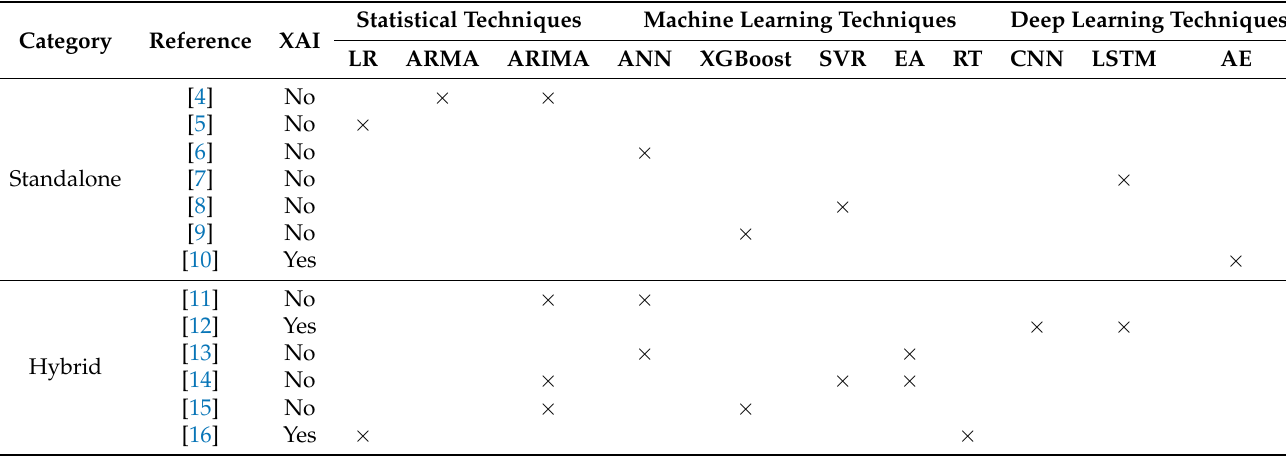
Table 2. Related works on time series energy